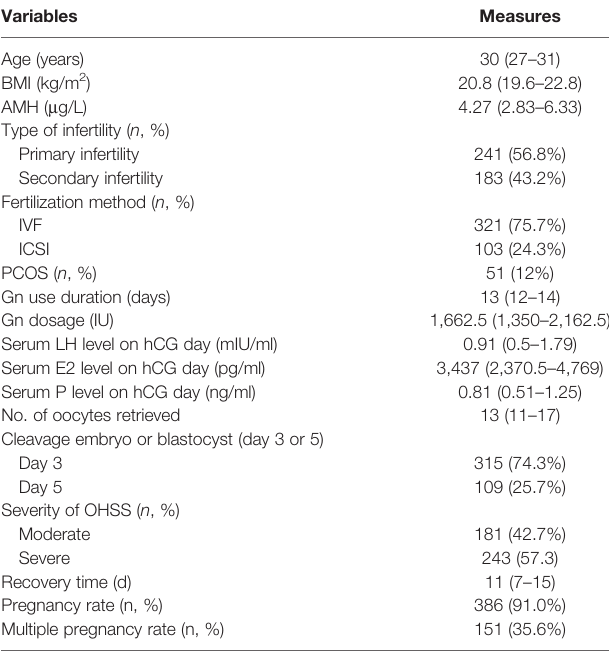
TABLE 2 | Baseline characteristics and cycle outcomes.